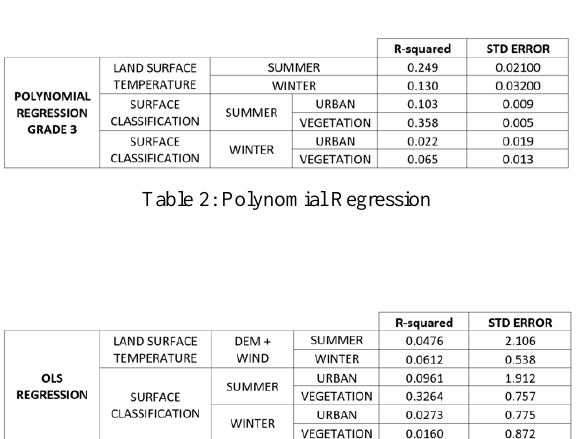
Table 3: Ordinary Least Square Regression